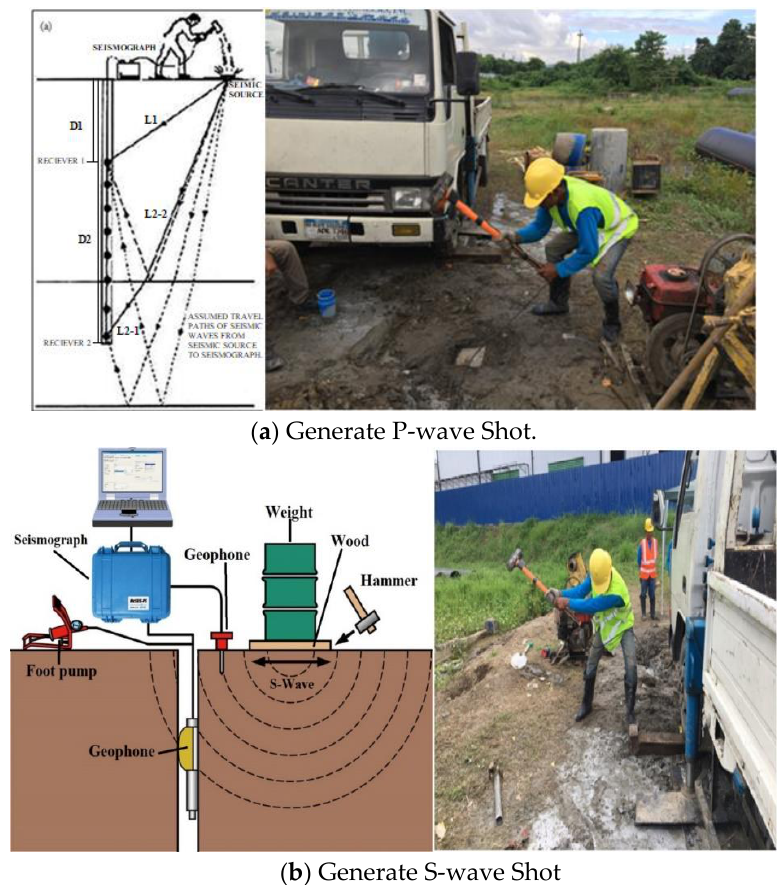
Figure 9. Seismic down-hole data acquisition, ( a ) P-wave ( b ) S-wave.